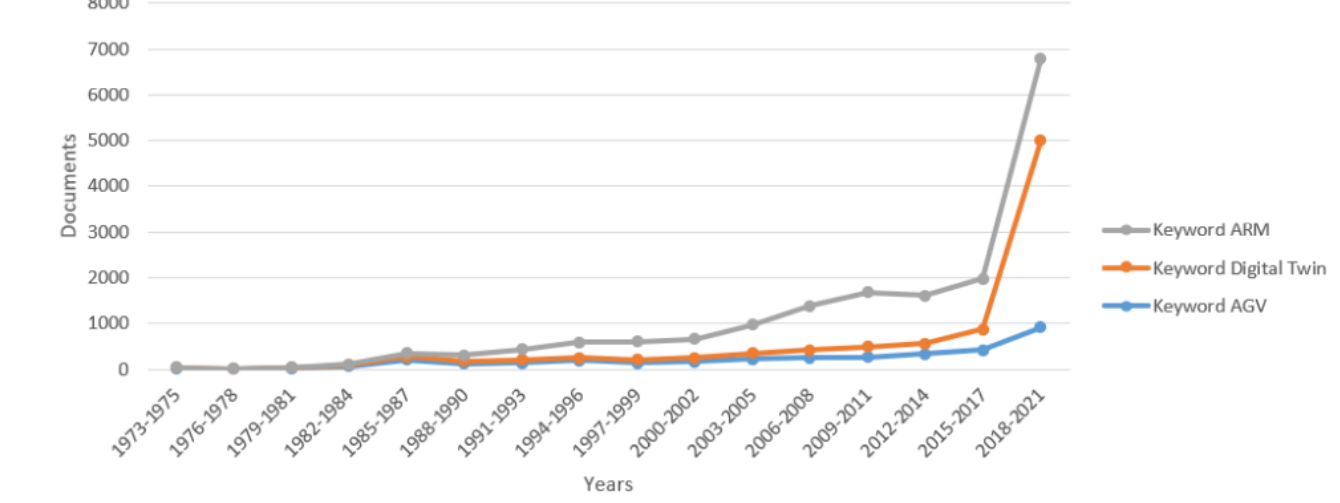
Figure 3. Number of publications regarding digital twins, AMR, and AGV according to the Scopus database.